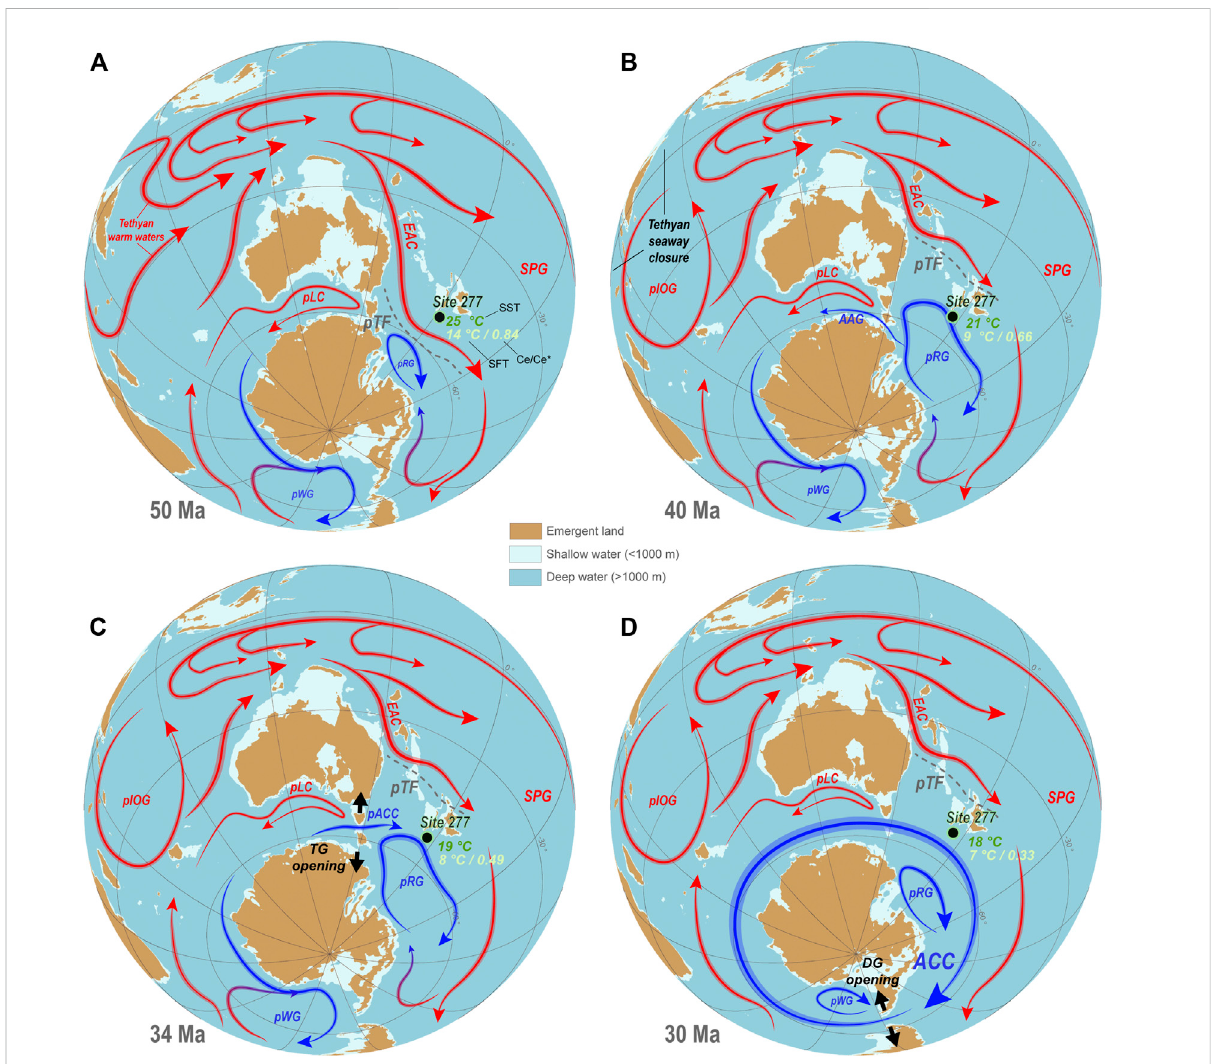
FIGURE 9 Paleogeographic reconstructions illustrating possible paleoceanographic evolutions along the Eocene-Oligocene interval. (A) , (B) , (C) and (D) correspond to snapshots at 50 Ma, 40 Ma, 34 Ma and 30 Ma, respectively. Paleogeographic and paleobathymetric data are from Straume et al. (2020).ReconstructionswererealizedusingtheGPlatesoftware.Arrowsrepresentwarmer(red)andcooler(blue)oceaniccurrents.Theyresultfrom an attempt of harmonization of several global and regional studies coupled with the results of the present study (this study and Nelson and